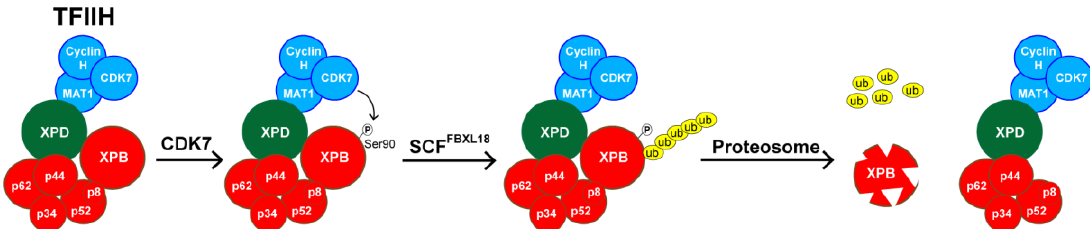
Figure 6. Schematic of the spironolactone-induced XPB degradation pathway. In response to spironolactone treatment, the XPB subunit of TFIIH becomes phosphorylated on Ser90 by CDK7, which then promotes poly-ubiquitination of XPB by the SCF FBXL18 E3 ubiquitin ligase to induce degradation by the proteasome.